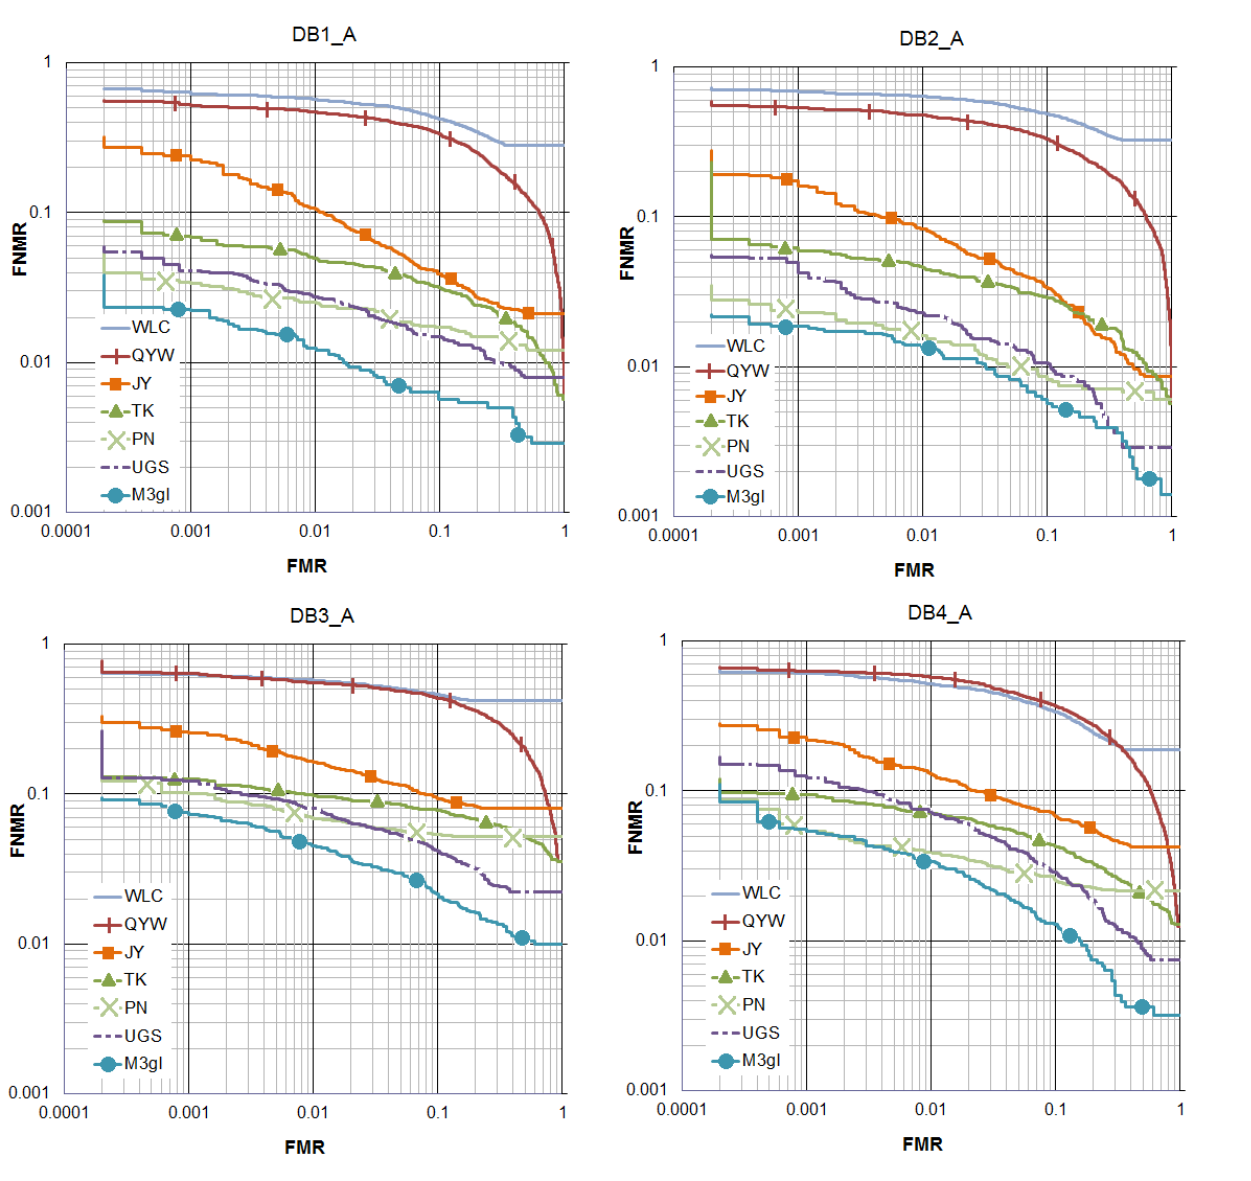
Figure 5. ROC curves with the performance of the compared algorithms in